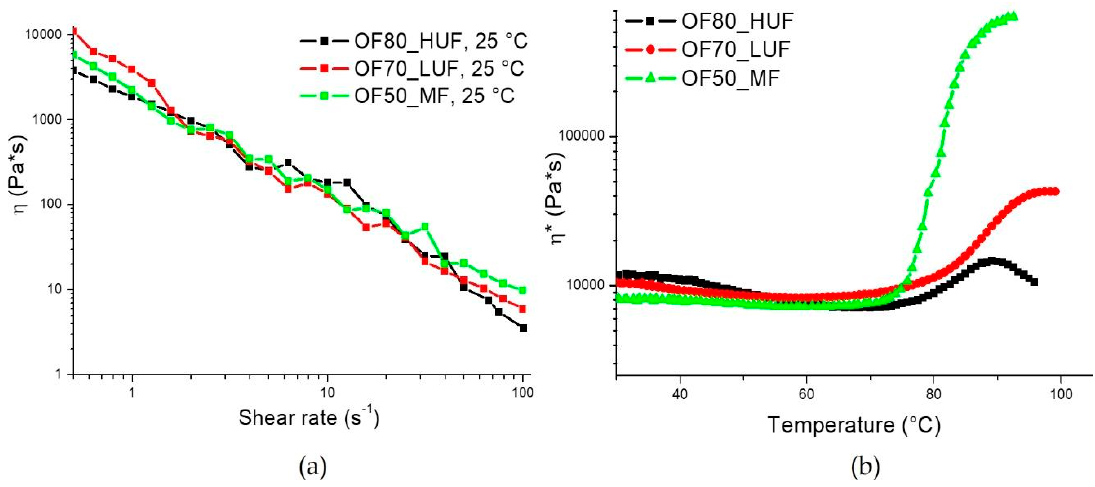
Figure 2. ( a ) Steady rate sweep tests at room temperature and ( b ) dynamic temperature ramp tests on OF80_HUF, OF70_LUF and OF50_MF samples.